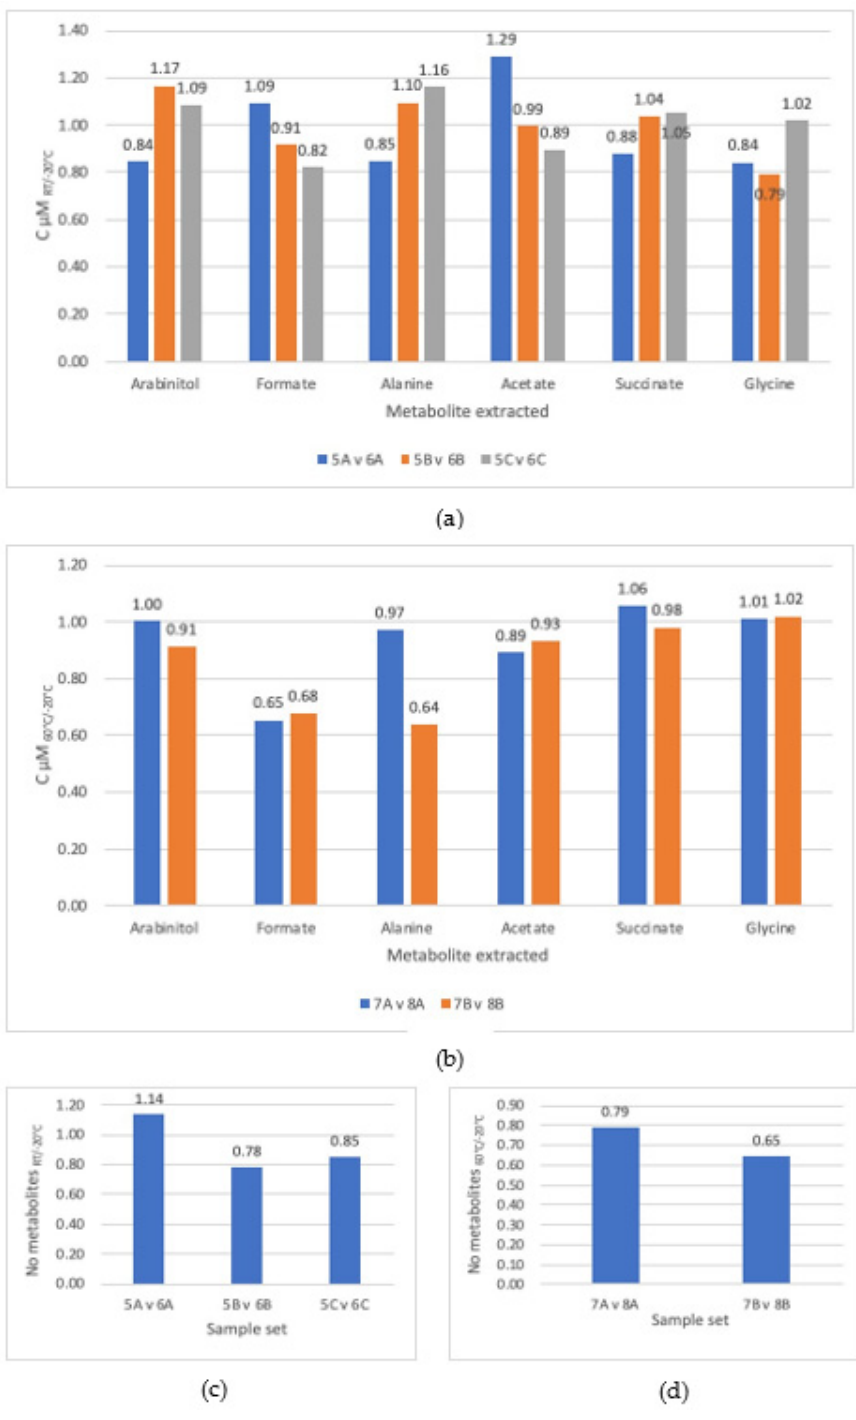
Figure 3. ( a ) Difference in concentrations between RT (5) and − 20 ◦ C (6) C µ MRT/ − 20ºC incubation temperature for triplicates A–C. Numbers below 1 indicate an increased extraction for − 20 ◦ C incubation. ( b ) Difference in concentrations between 60 ◦ C (7) and − 20 ◦ C (8) incubation temperatures for triplicates A–C. Number below 1 indicate an increased extraction for − 20 ◦ C incubation. ( c ) Difference in the number of different metabolites extracted between RT (5) and − 20 ◦ C (6) incubation temperatures. NRT/ − 20 ◦ C for triplicates A–C. Numbers below 1 indicate an increased extraction for − 20 ◦ C incubation ( d ) Difference in the number of different metabolites extracted between 60 ◦ C (7) and − 20 ◦ C (8) incubation temperatures N60 ◦ C / − 20 ◦ C for triplicates A–C. Numbers below 1 indicate an increased extraction for − 20 ◦ C incubation. Numbers above the bars indicate measured